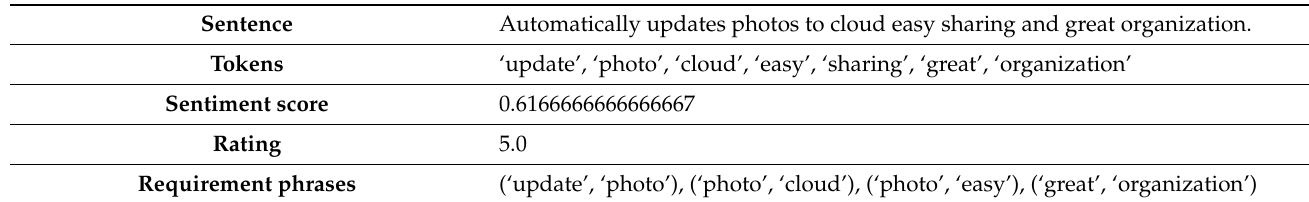
Table 1. An example of preprocessing results and requirement phrase extraction for